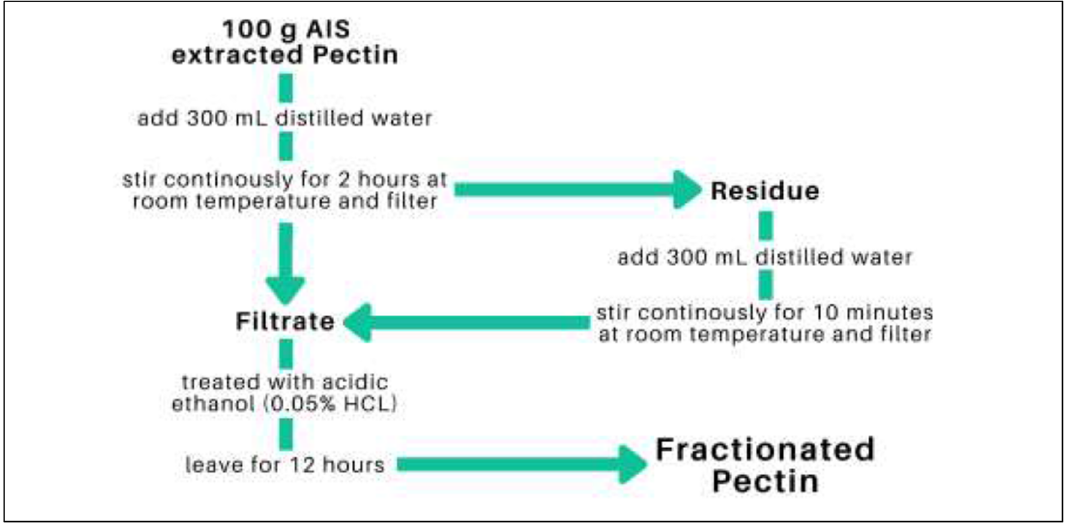
Figure 3. Schematic diagram for the fractionation of